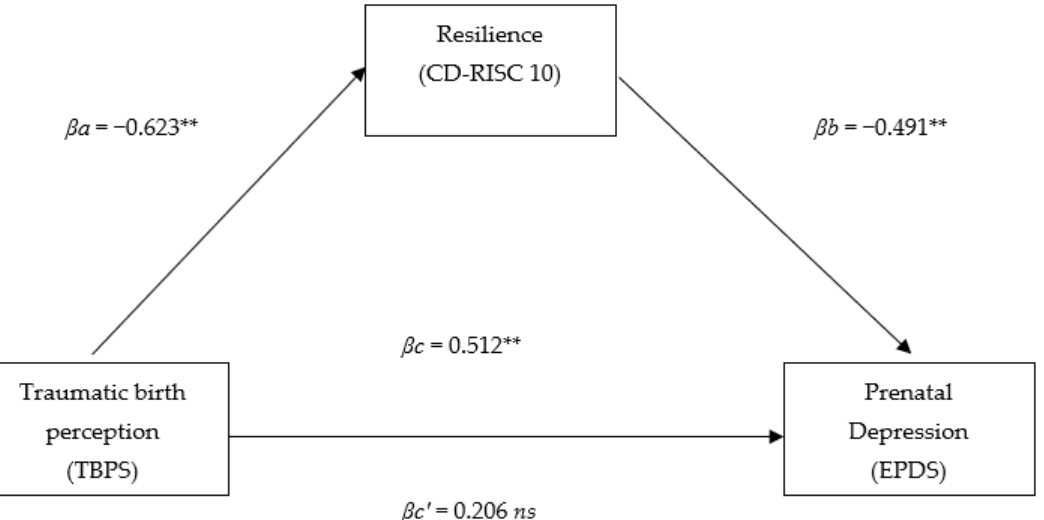
Figure 1. Model of relationships between pandemic-related stress, resilience, and prenatal depression in the study sample. * p < 0.05, ** p < 0.001, ns —non-significant.